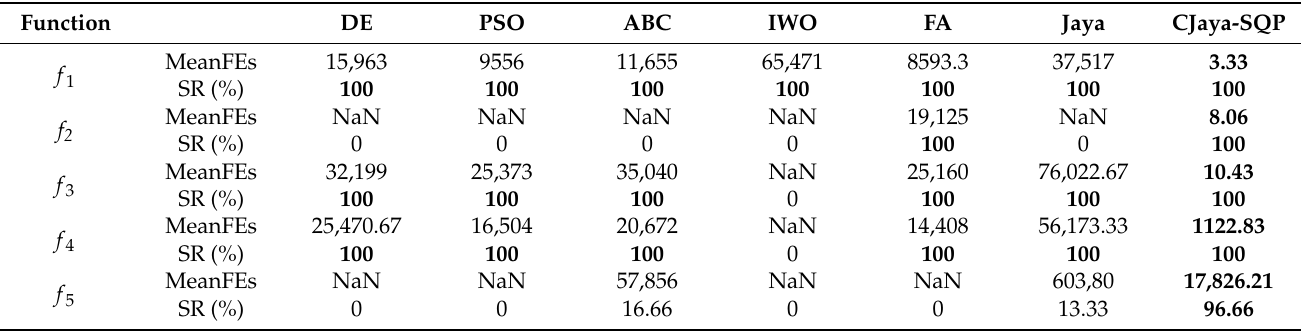
Table 6. Mean function evaluations required to reach the threshold value and success rate by various algorithms for 30-dimensional functions over 30